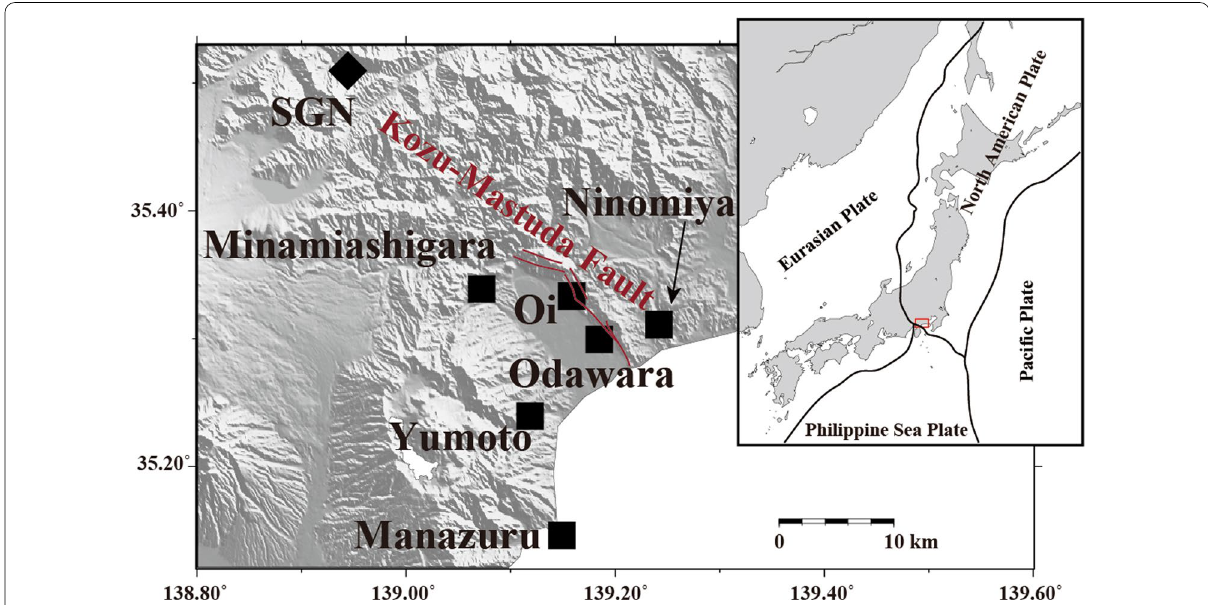
Fig. 1 Map showing the observation wells of the HSRI. Squares indicate the locations of the wells by the HSRI. A diamond shows the F-net station, SGN. Red lines indicate the surface traces of the Kozu-Matsuda fault (Yamazaki 1993). Plate boundaries are indicated by thin lines in the map on the right-hand